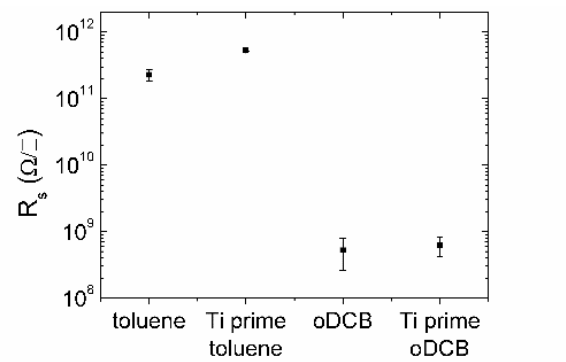
Figure 3. Sheet resistances measured on a set of minimum three devices for each kind of